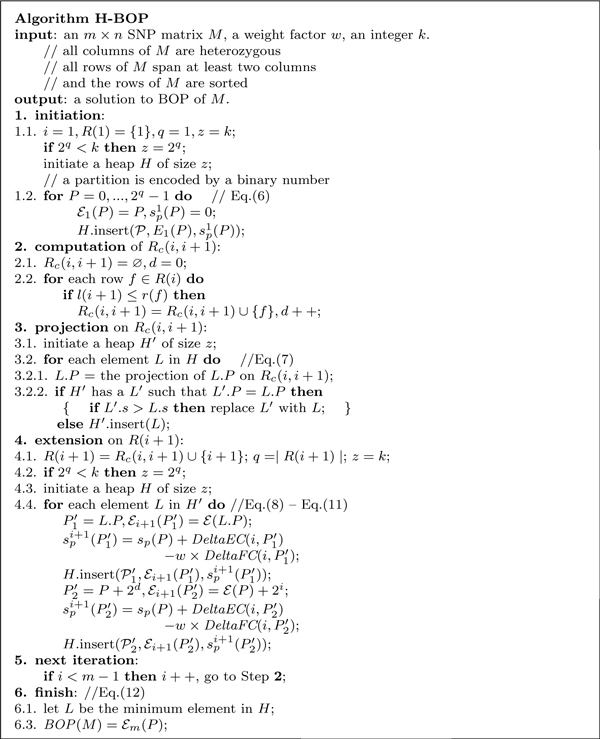
H-BOP Algorithm.